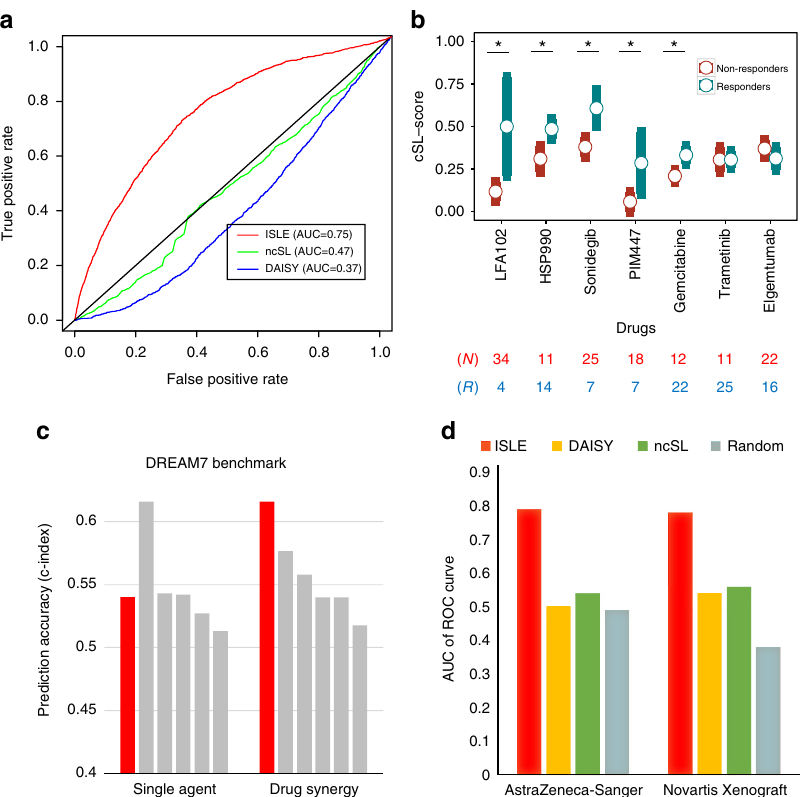
Fig. 2 ISLE-based prediction of in vitro and in vivo drug response. a Prediction of in vitro drug response using drug-cSL-network in the CCLE 58 collections. The ROC curve compares the prediction performance of ISLE, ncSL, and DAISY (Methods). b Predicting in vivo drug response using drug-cSL-network. Mouse xenograft samples marked as responders (blue) show higher cSL-scores compared to the samples marked as non-responders (red). The X -axis shows seven drugs where suf fi cient drug response data are available and the Y -axis depicts the cSL-score (divided by the total number of SL partners to guide visualization, mean and s.e.m). (* marks the fi ve drugs that are signi fi cantly predicted after multiple hypothesis correction (FDR-corrected Wilcoxon rank sum P < 0.2), and drugs are listed in order of signi fi cance). c Benchmarking ISLE-based drug response prediction versus the DREAM7 challenge. The fi gure shows prediction accuracy (evaluated using a variant of concordance index (Methods); Y -axis) of ISLE (red) and top fi ve approaches (gray) both for the drug response to single agent (left columns) and drug combinations (right columns). d Predicting drug synergy. The AUC of ROC curves displaying the SL-based prediction accuracy of synergistic drug combination screens of a recent DREAM challenge, and a large collection of mouse xenograft models 59 . Results are shown for ISLE cSL interactions (red) and compared with the DAISY SL-network (yellow), ncSL network (green), and randomly permuted networks